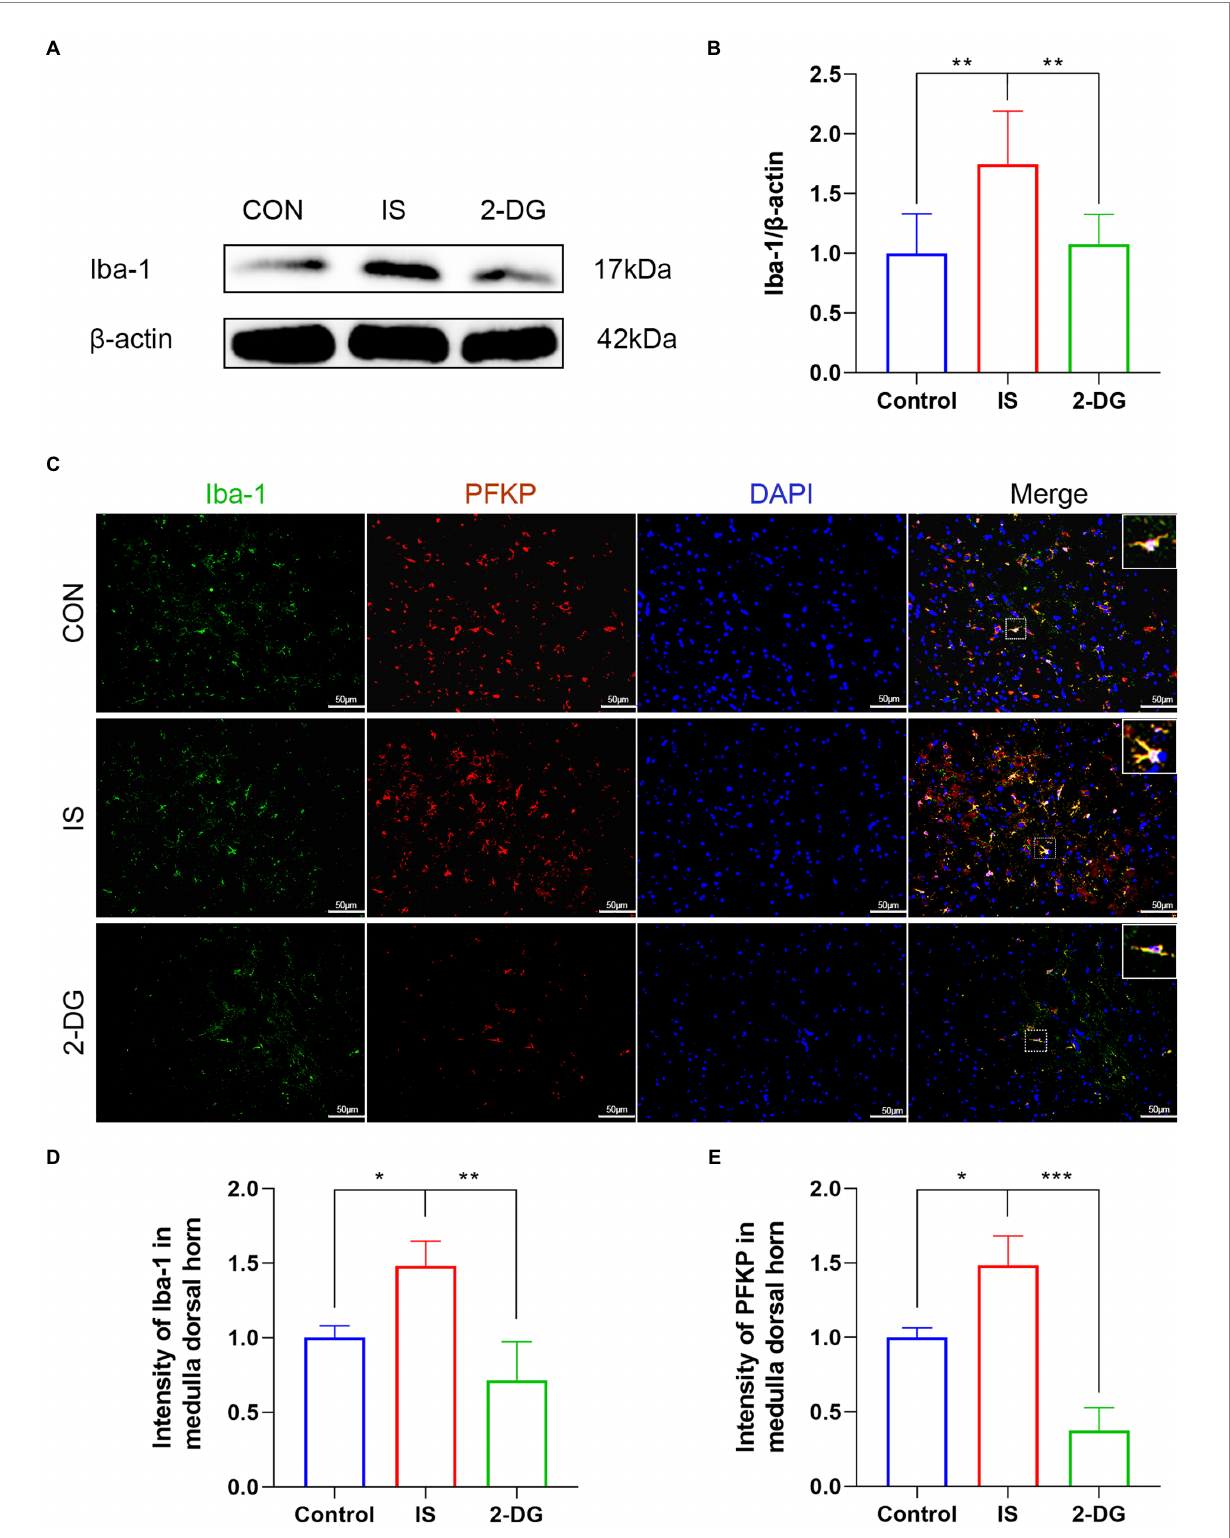
FIGURE 5 2-DG inhibited IS-induced microglial activation in the medulla dorsal horn. (A) WB of Iba-1 protein in the medullary dorsal horn. (B) Infusion of IS increased Iba-1 protein levels in the medulla dorsal horn, and the expression of Iba-1 was significantly decreased in the 2-DG group compared with the IS group. Data were expressed as mean ± SD ( n = 3 per group). ** p < 0.01. (C) The immunoreactivity of Iba-1 and PFKP in the medullary dorsal horn. (D) Quantification of Iba-1 immunofluorescence intensity in medulla dorsal horn. Data were expressed as mean ± SD ( n = 3 per group). * p < 0.05, ** p < 0.01. (E) Quantification of PFKP immunofluorescence intensity in medulla dorsal horn. Data were expressed as mean ± SD ( n = 3 per group). * p < 0.05, *** p <